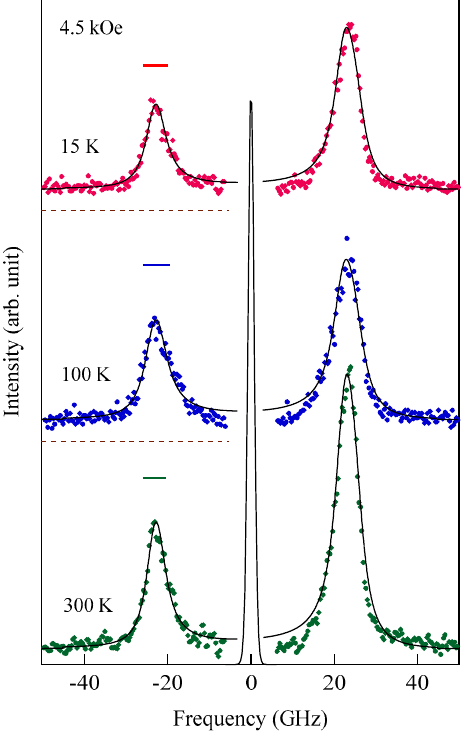
Figure 37. Temperature development of the BLS spectrum in a temperature range between 300 and 15 K under a magnetic field of 4.5 kOe. The baseline of each spectrum, indicated by the broken line, was properly shifted for clarity. The solid lines give the numerical fits obtained by the CM theory, and the horizontal bars show the damping constant of the calculated spectra [108].